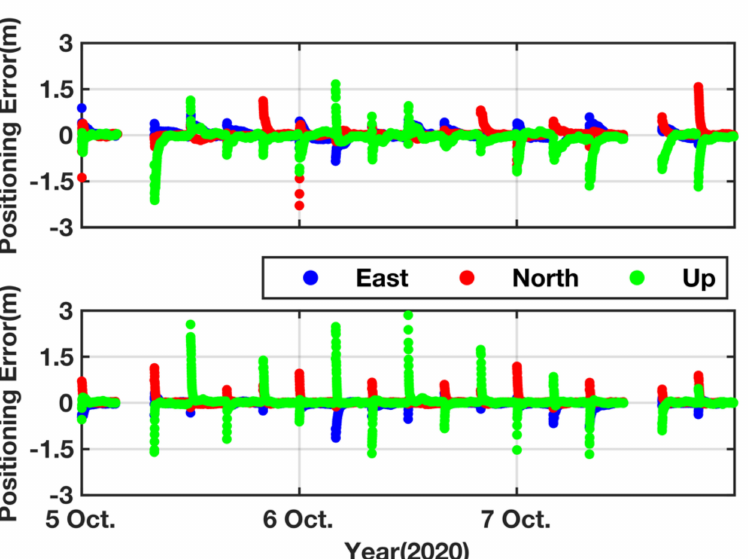
Figure 13. Kinematic PPP positioning errors at the BJF1 station (top panel for PPP-B2b and bottom panel for GBM).